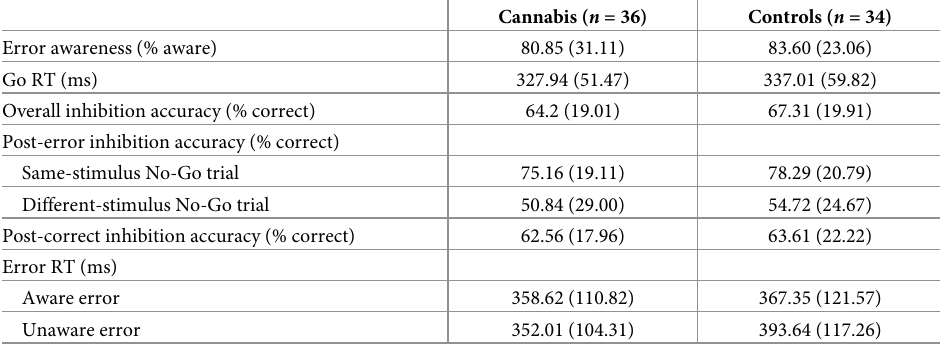
Table 3. Learning from inhibition errors task performance indices.